Question: Based on the figure, does the quantity rise or fall?
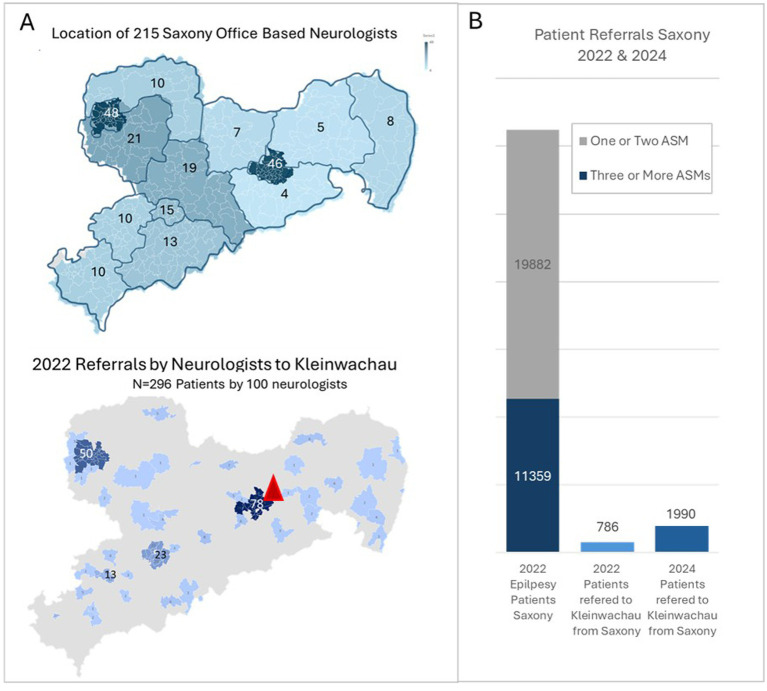
Answer: increasing